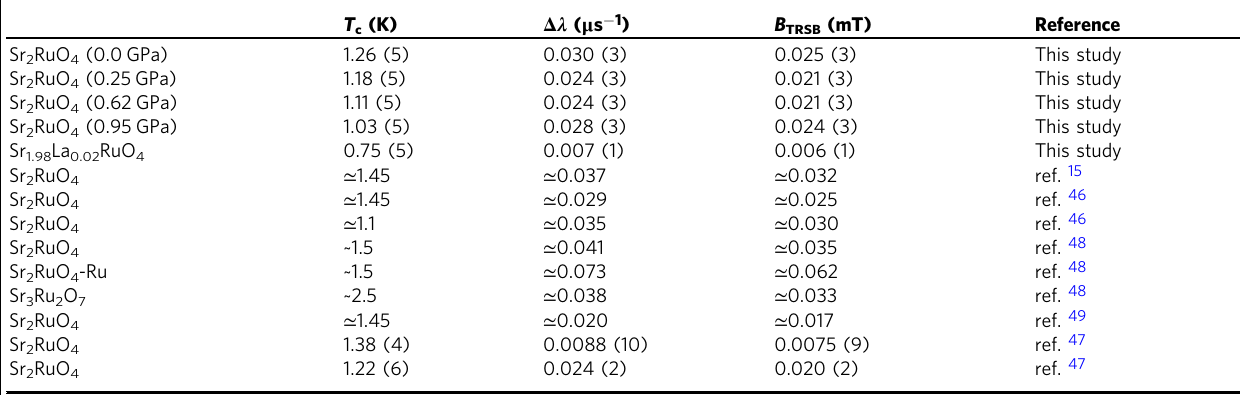
Table 1 Enhancement of the exponential relaxation rates Δ λ and corresponding values of the spontaneous magnetic fi elds B = Δ λ / γ μ caused by formation of TRSB state in Sr 2 RuO 4 and related compounds. TRSB